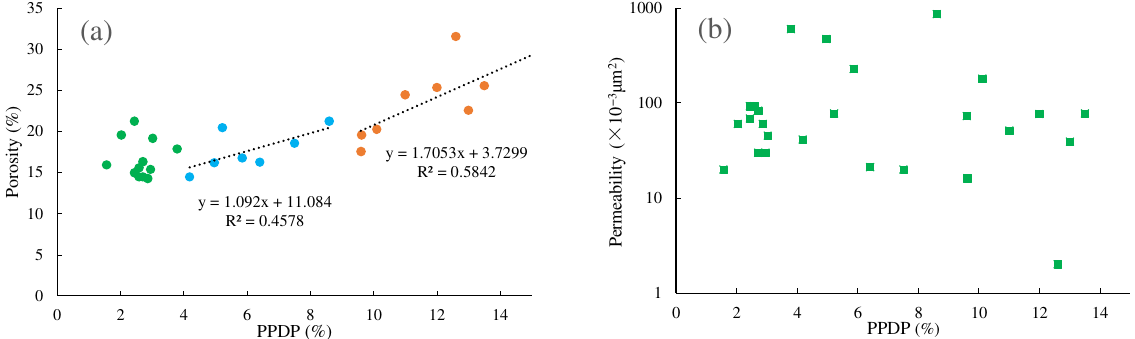
Figure 17. Relationship between plane porosity of dissolution pores. ( a ) porosity; ( b ) permeability of Ek1 Formation in the Wang Guantun area.